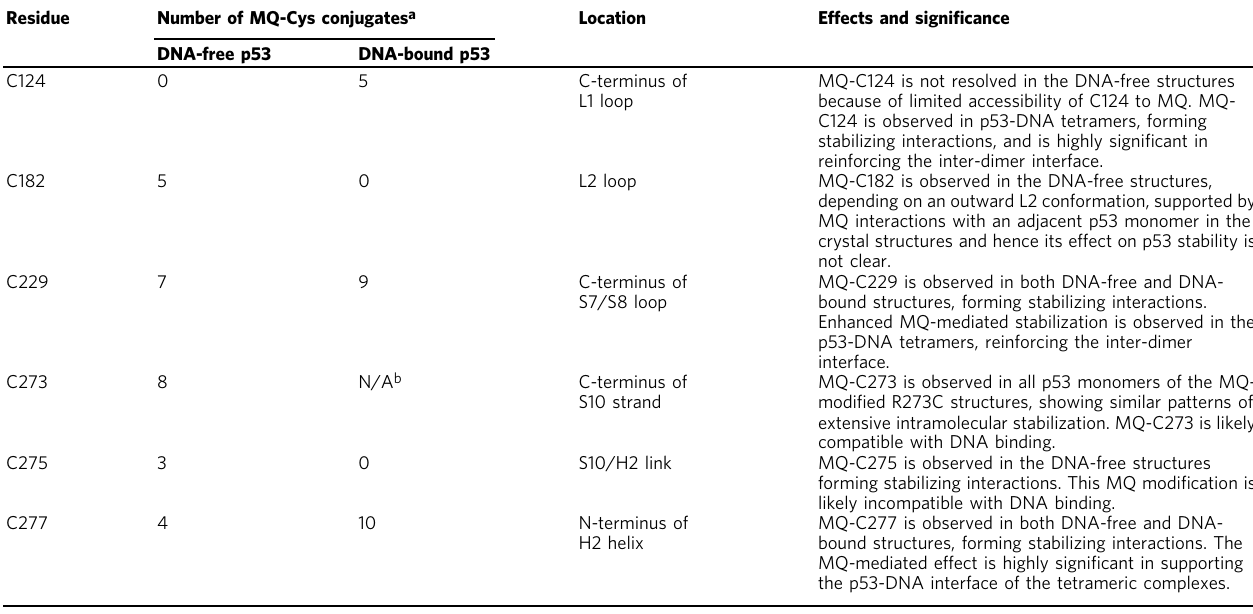
Table 2 Effects and signi fi cance of MQ-modi fi ed Cys